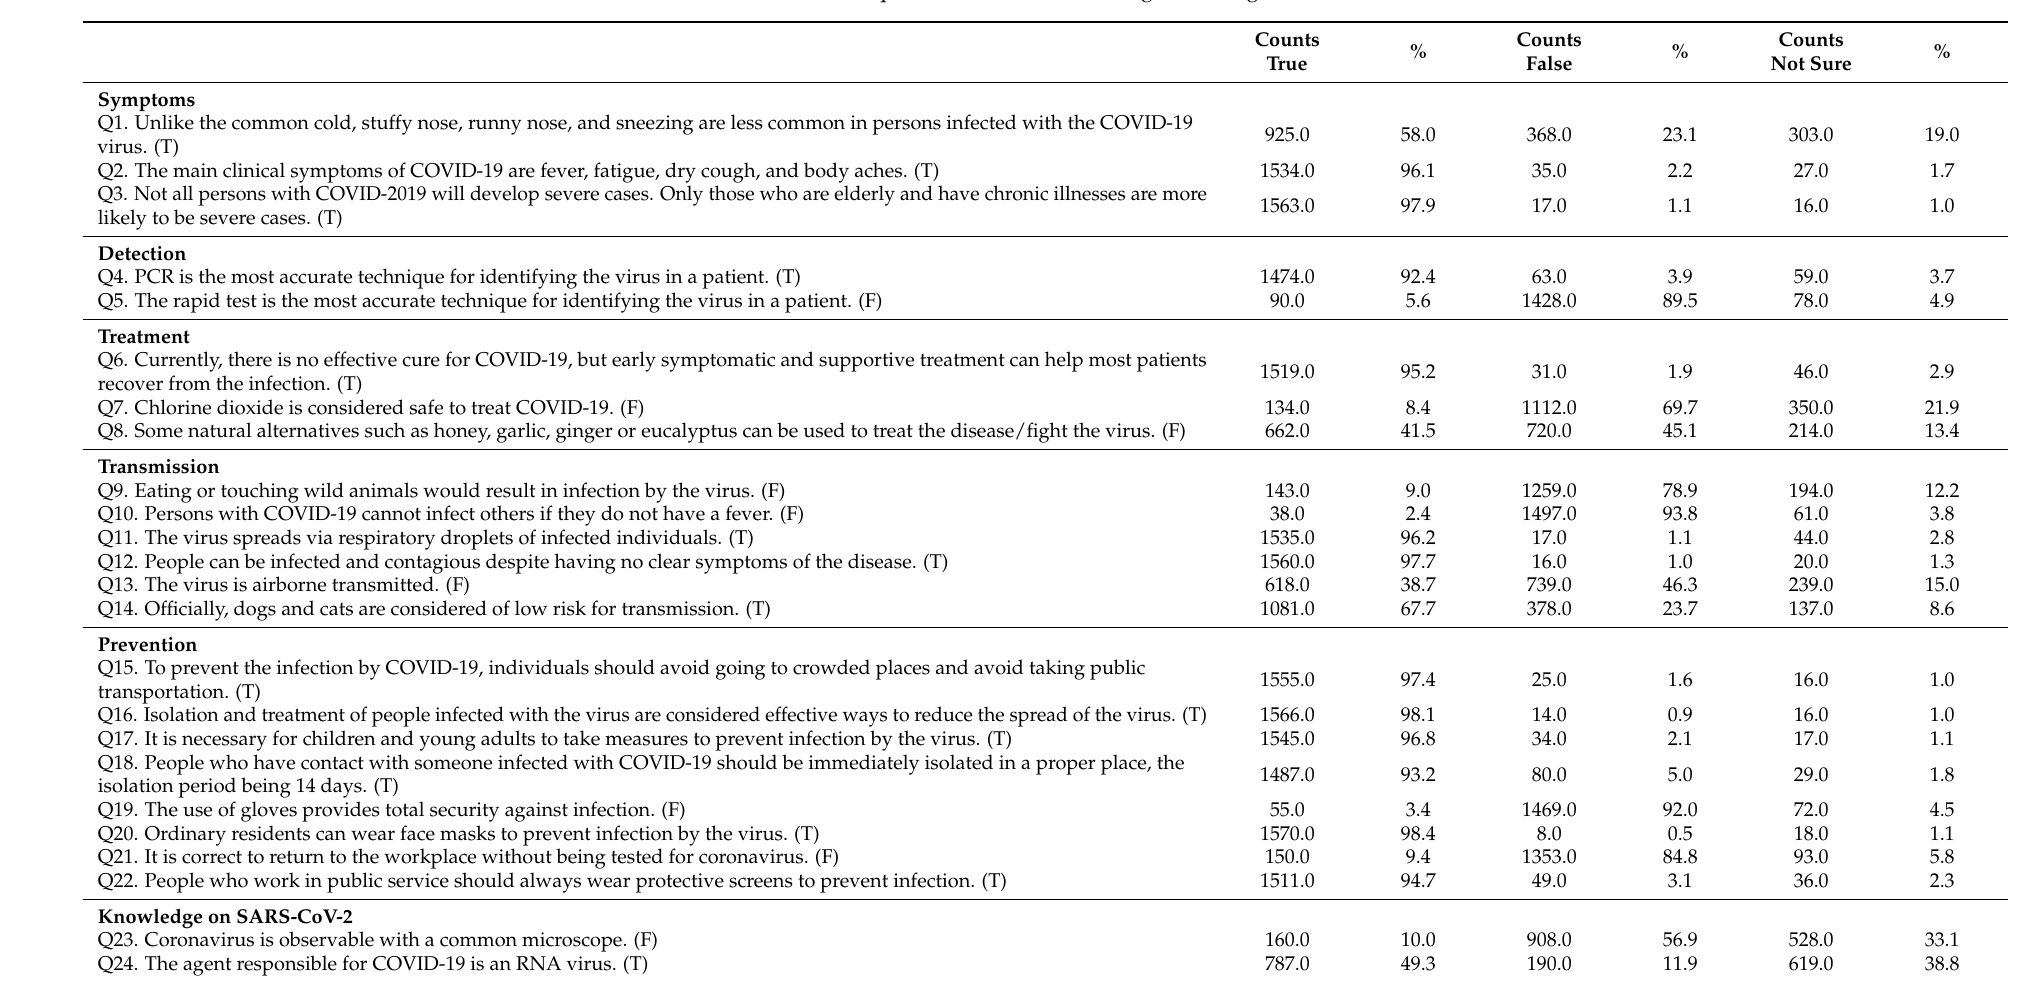
Table 3. True/false questions used for assessing knowledge of